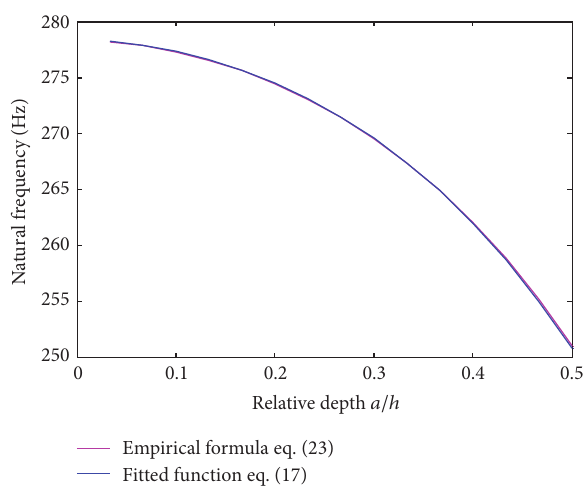
Figure 8: Natural frequencies of the fitted function and the empirical formula.